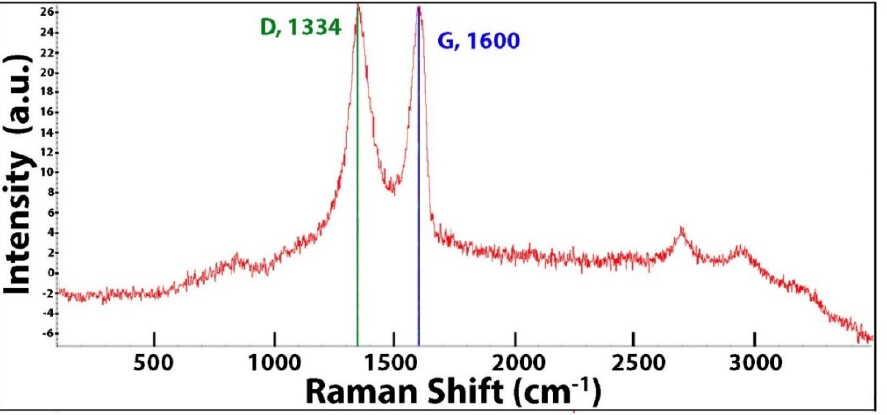
Figure 2. Raman spectrum for carbon nanotori structures.